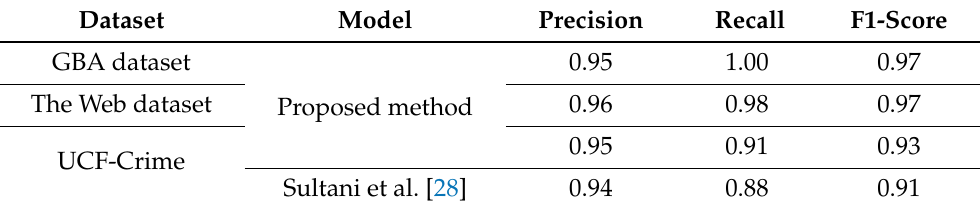
Table 4. Precision, recall and f1-score obtained with the proposal for anomaly detection in UCF-crime, GBA and The Web datasets, and comparison with [28] in